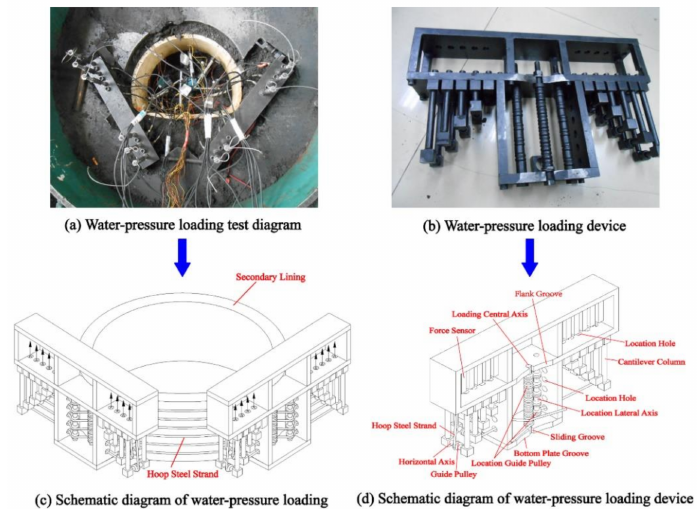
Figure 5. Fully closed prestressed equivalent water pressure (hoop) loading device.